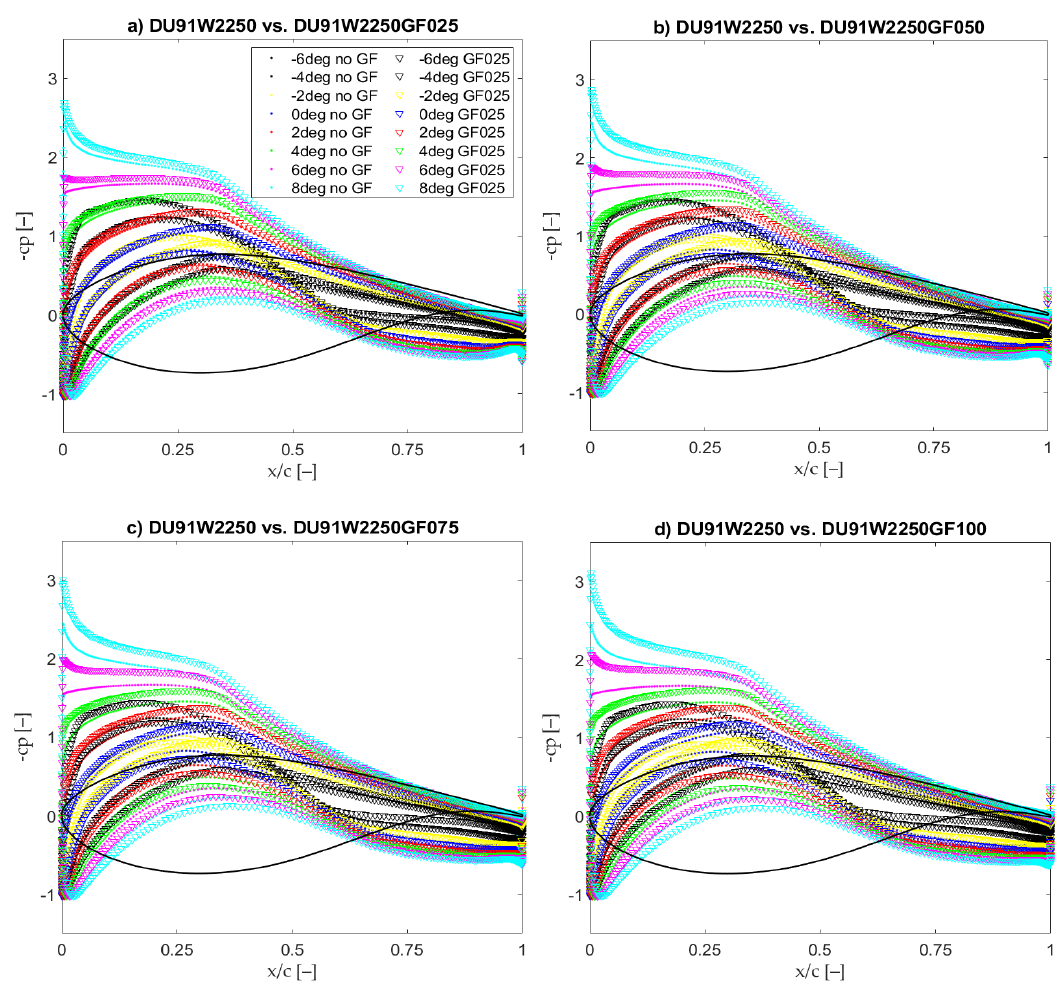
Figure 6. Pressure coefficient cp comparison between the clean airfoil DU91W2250 (no GF) and the best cases: ( a ) DU91W(2)250GF025; ( b ) DU91W(2)250GF050; ( c ) DU91W(2)250GF075; ( d ) DU91W(2)250GF100.